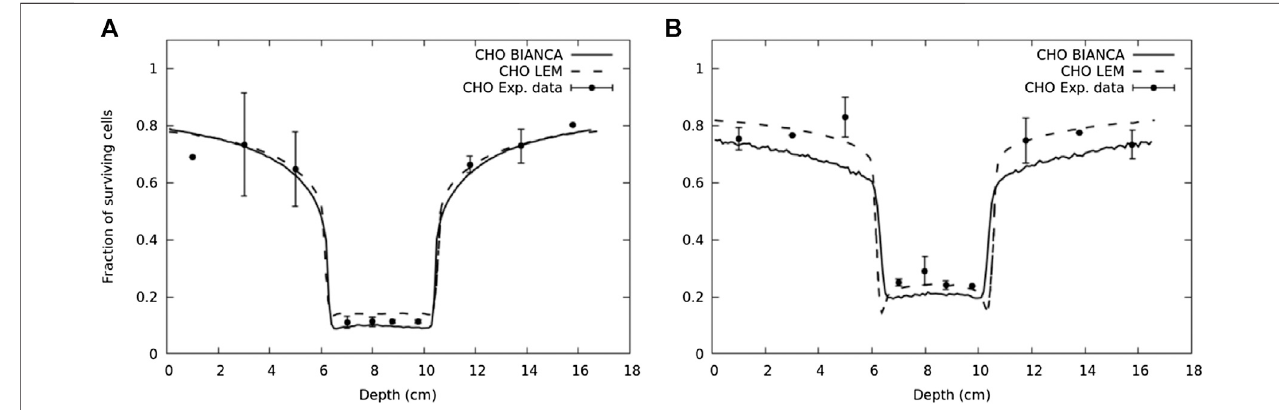
FIGURE 7 | Surviving fraction for CHO cells in a typical two-port irradiation with carbon ions (panel (A) ) and protons (panel (B) ) [188]. The solid lines represent the predictions performed by BIANCA interfaced to FLUKA, the points are experimental data taken from Ref. 189, and the dashed lines represent the prediction performed by LEM model